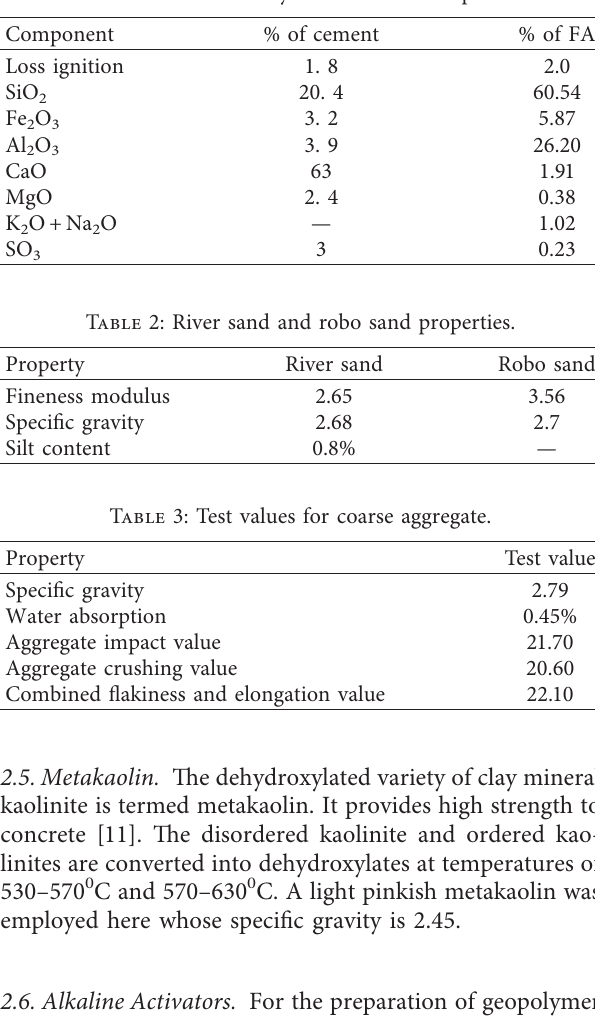
Table 1: Cement and fly ash chemical composition.